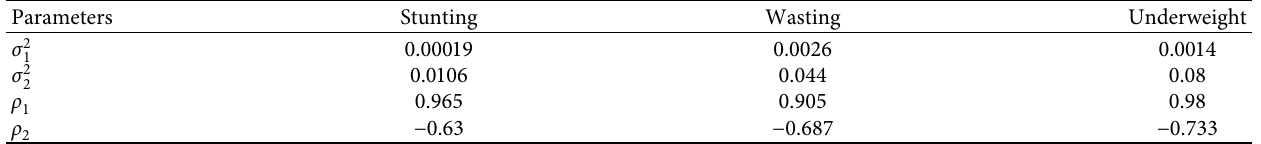
Table 1: Parameters estimator of STFH